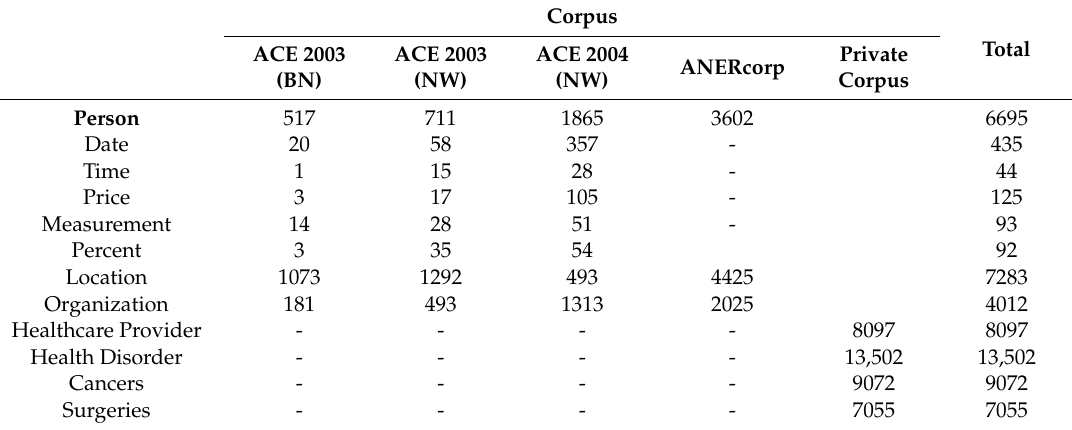
Table 3. Information of the Arabic corpora tested in this